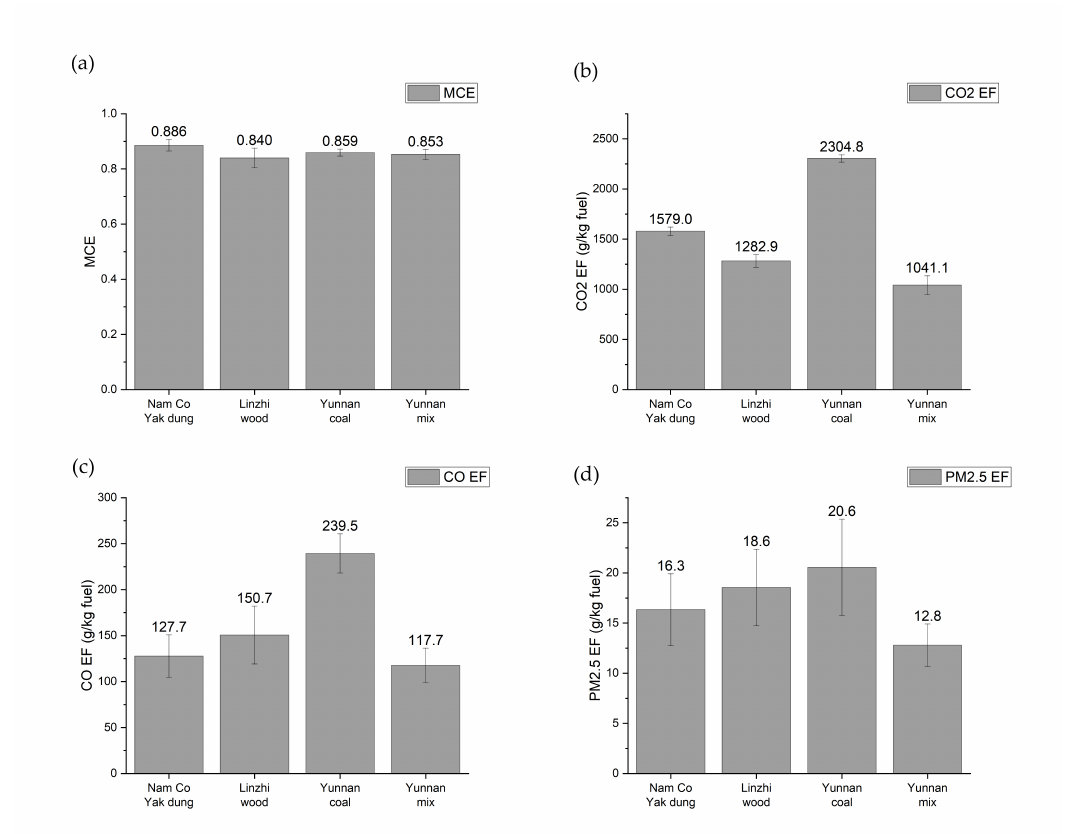
Figure 9. Comparison of emission parameters between sites and fuels: ( a ) Modified combustion efficiency (MCE); ( b ) Emission factor for CO 2 ; ( c ) Emission factor for CO ; ( d ) Emission factor for PM 2.5